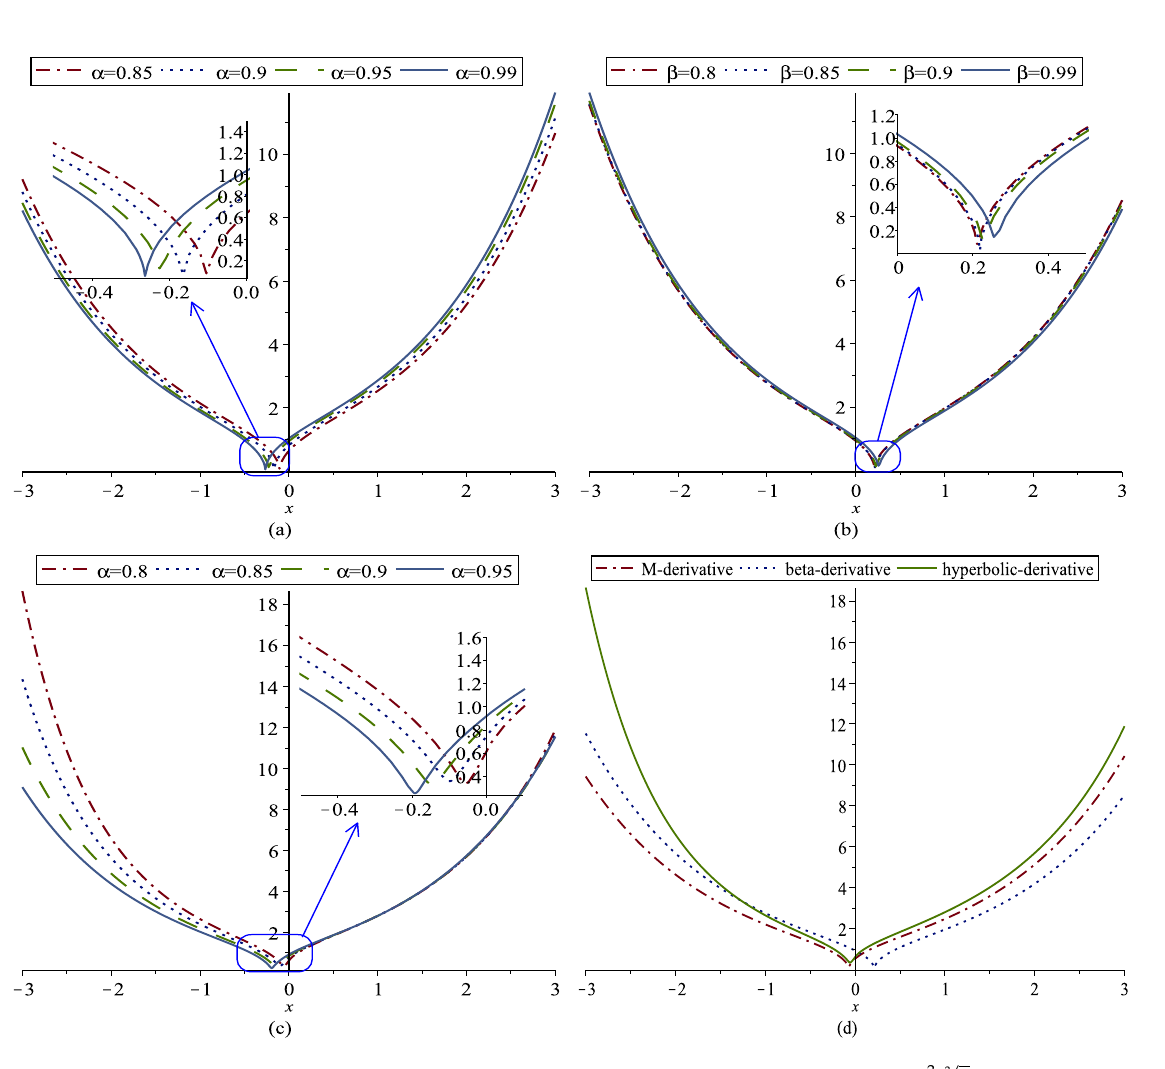
Figure 4. Exact solutions with a = c = 2, λ 2 = λ 3 = t = 1, α 1 = 3 and various α w.r.t. M-derivative (18), ( b ) various β w.r.t. beta-derivative (19) ( c ) various α w.r.t. hyperbolic-derivative (20) ( d ) α = β = 0.8, and various